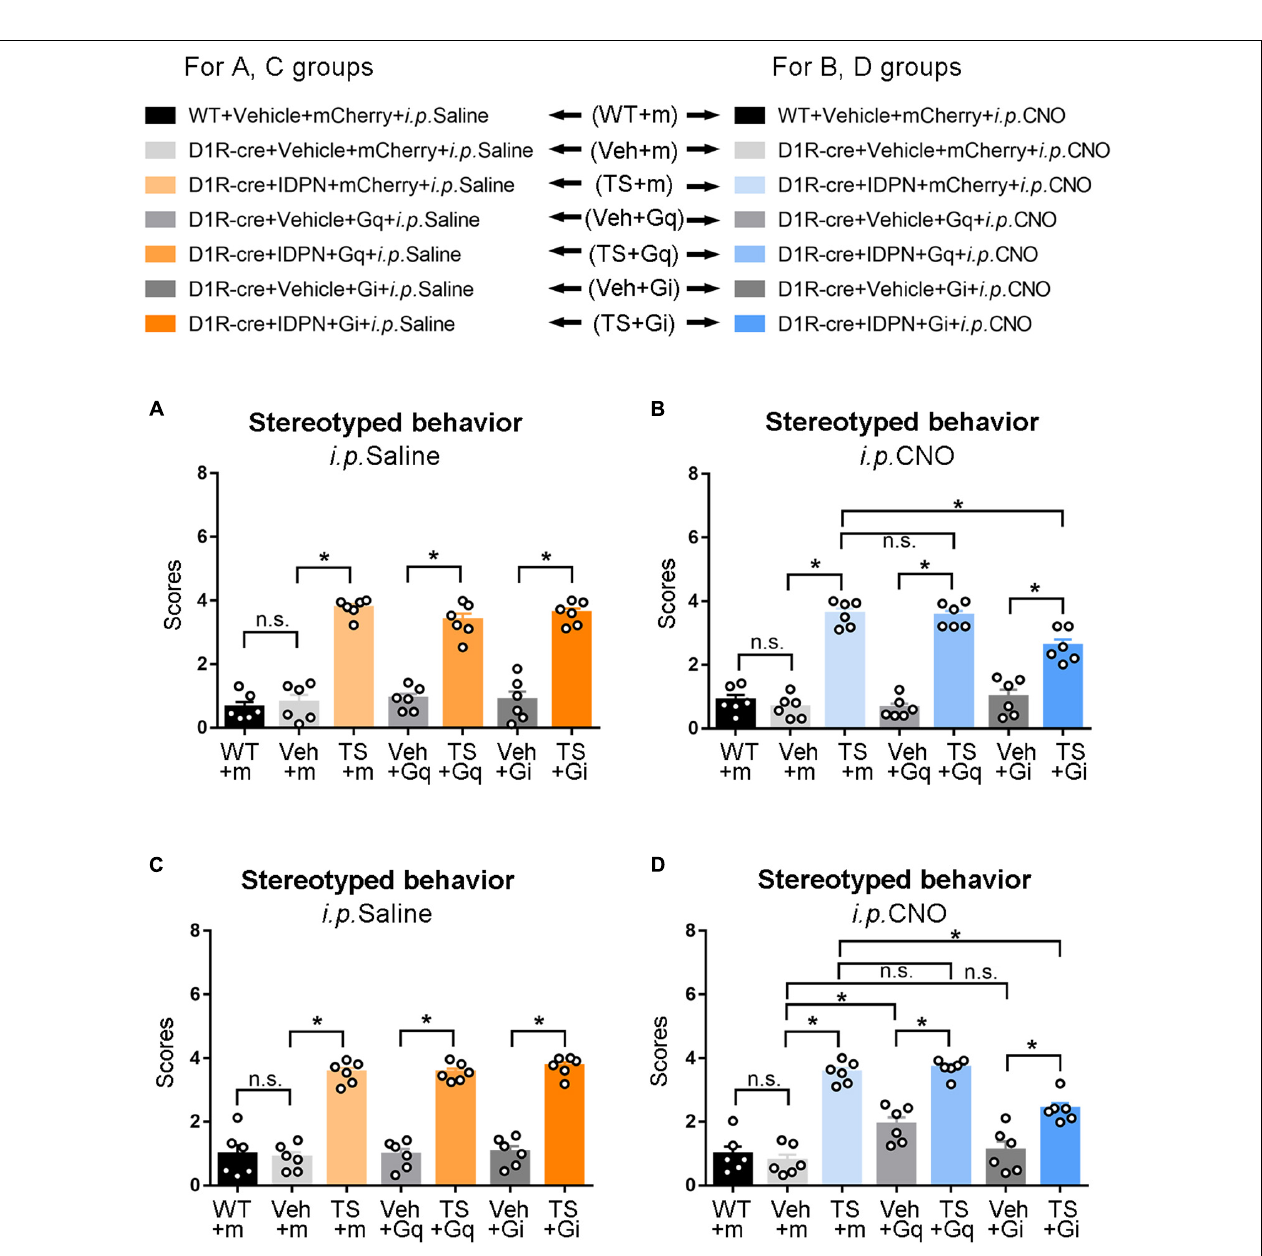
FIGURE 2 | Effects of activation or inhibition of the D1R-containing neurons in the SNpc and dSTR on stereotyped behavior in mice. (A) Evaluations of stereotyped behavior scores of mice injected with virus in the SNpc 30 min after the injection of saline (i.p. Saline) in the WT + Vehicle + mCherry + i.p. Saline group (WT + m), D1R-cre + Vehicle + mCherry + i.p. Saline group (Veh + m), D1R-cre + IDPN + mCherry + i.p. Saline group (TS + m), D1R-cre + Vehicle + Gq + i.p. Saline group (Veh + Gq), D1R-cre + IDPN + Gq + i.p. Saline group (TS + Gq), D1R-cre + Vehicle + Gi + i.p. Saline group (Veh + Gi), D1R-cre + IDPN + Gi + i.p. Saline group (TS + Gi) on day 23. (B) Evaluations of stereotyped behavior scores of mice injected with virus in the SNpc 30 min after the injection of CNO (i.p. CNO) in the WT + Vehicle + mCherry + i.p. CNO group (WT + m), D1R-cre + Vehicle + mCherry + i.p. CNO group (Veh + m), D1R-cre + IDPN + mCherry + i.p. CNO group (TS + m), D1R-cre + Vehicle + Gq + i.p. CNO group (Veh + Gq), D1R-cre + IDPN + Gq + i.p. CNO group (TS + Gq), D1R-cre + Vehicle + Gi + i.p. CNO group (Veh + Gi), D1R-cre + IDPN + Gi + i.p. CNO group (TS + Gi) on day 23. (C) Evaluations of stereotyped behavior scores of mice injected with virus in the dSTR 30 min after the injection of saline (i.p. Saline) in each group on day 23. (D) Evaluations of stereotyped behavior scores of mice injected with virus in the dSTR 30 min after the injection of CNO (i.p. CNO) in each group on day 23. Data are expressed as mean ± SEM ( n = 6 mice in each group), and the black line segment indicates the differences between groups, * represents P < 0.05 between marked groups, n.s. represents P > 0.05 between marked groups.